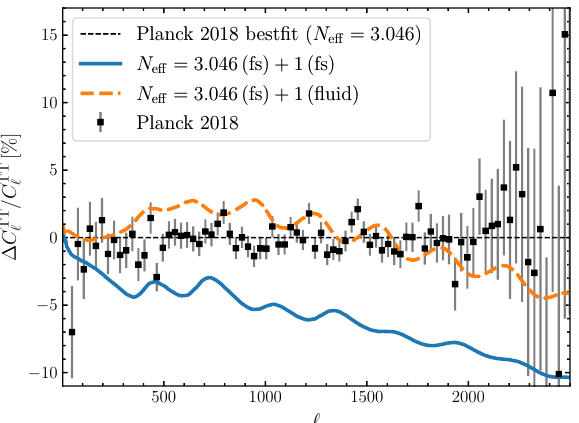
Figure 3. Percentage variation of the CMB temperature power spectrum with respect to Planck 2018 best fit. The spectra are computed fixing θ s , Ω b and z eq , and increasing N eff by adding one additional species that behaves either like standard neutrinos, i.e., free streaming (fs, blue solid line), or like a fluid (orange dashed line). The shift of the acoustic peaks with respect to the reference ( N eff = 3.046) is out of phase in the two cases. The damping is reduced when the additional species behaves like a fluid. Planck 2018 measurements are shown for reference (black points with error bars). Notice that here, the reference value is N eff = 3.046, rather than the updated N eff = 3.044, for consistency with the best fit provided by the Planck